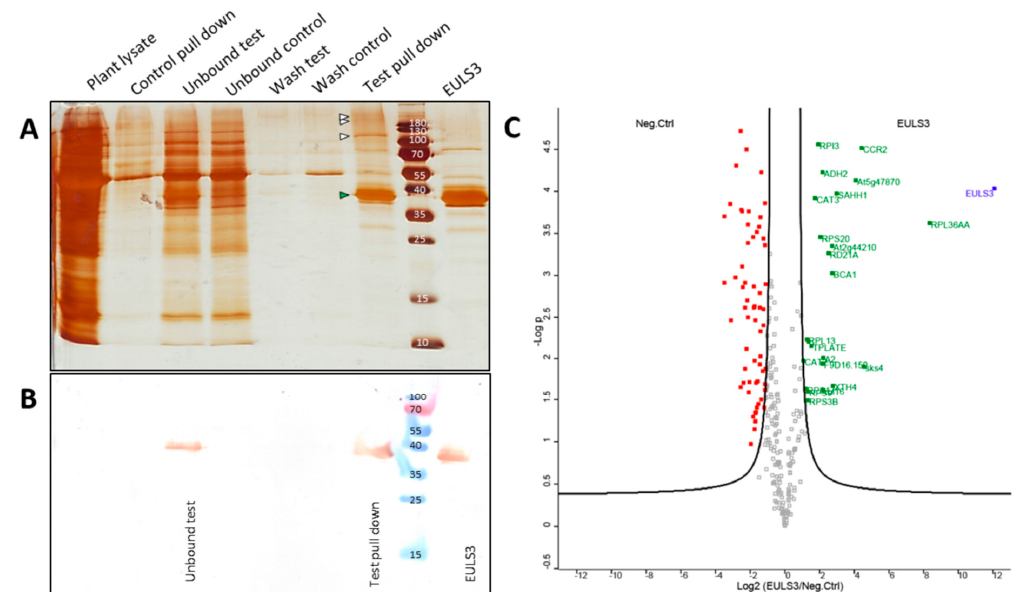
Figure 7. A pull down analysis of ArathEULS3. ( A ) Silver stained SDS-PAGE illustrating the protein patterns in the following order: crude plant lysate (prey), control pull down (Myc-trap ® beads incubated with plant lysate), proteins that did not bind to the beads for test and control pull-down, washes of Myc-trap ® beads, test pull-down (proteins eluted from the Myc-trap ® beads incubated with ArathEULS3 lectin), and purified recombinant ArathEULS3. ( B ) Western blot analysis using the anti-ArathEULS3 antibody. ( C ) Volcano plot of proteins identified by mass spectrometry ( N = 3). The ArathEULS3 protein is indicated in blue, 31 significantly enriched proteins are shown in